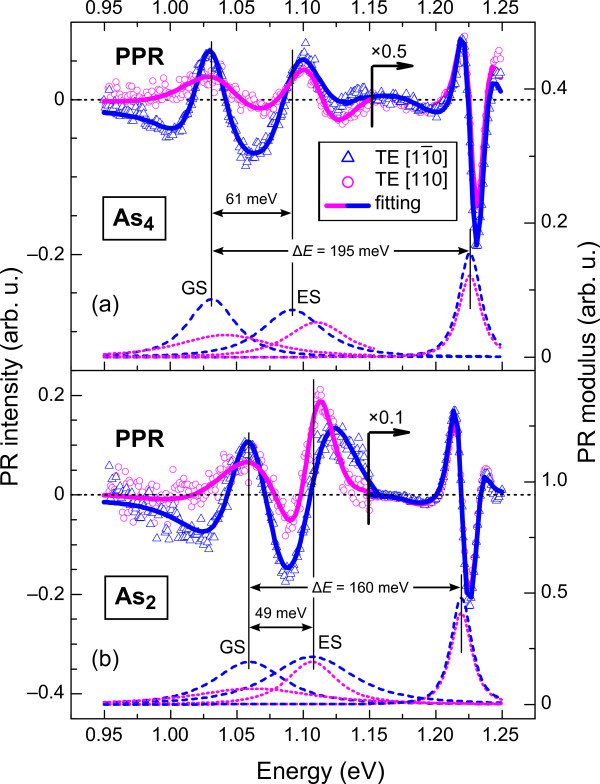
Room temperature PPR spectra at two perpendicular polarization angles (symbols). (a) As4-grown and (b) As2-grown QR35 samples. GS and ES denote optical transition energies in InGaAs QRs, involving ground and excited states, respectively. The modulus of individual PPR resonances are represented by dashed and dotted lines for the electric vector Ebeing parallel to the [11¯0] and [110] crystallographic axes, respectively.